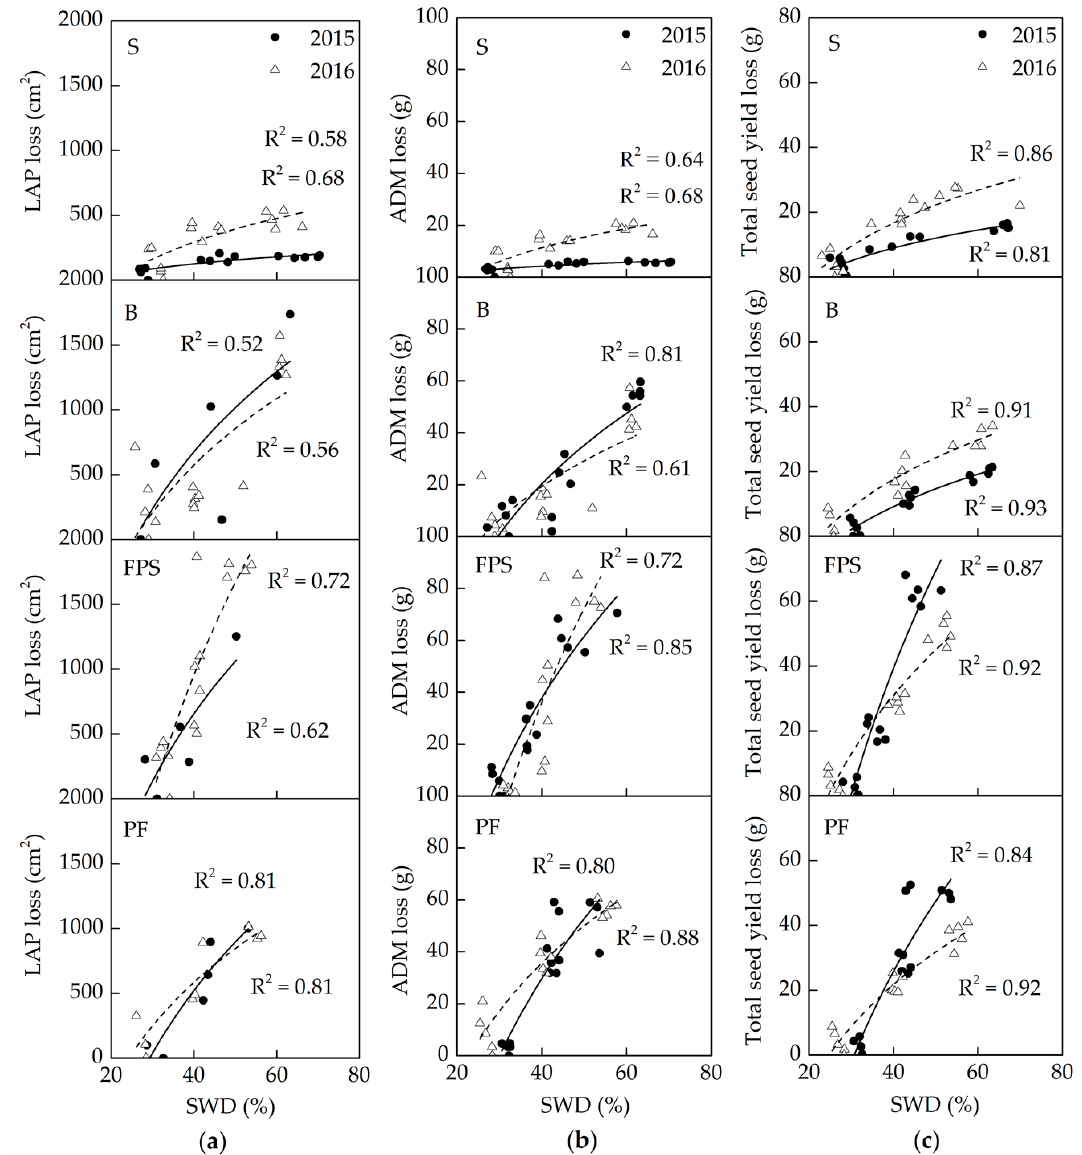
Figure 6. Relationships between: LAP loss ( a ); aboveground dry matter accumulation (ADM) loss ( b ); and total seed yield loss ( c ); and SWD for soybean exposed to water stress during different growth stages in 2015 and 2016. S, seedling stage; B, branching stage; FPS, flowering and pod-setting stage; PF, pod-filling stage.